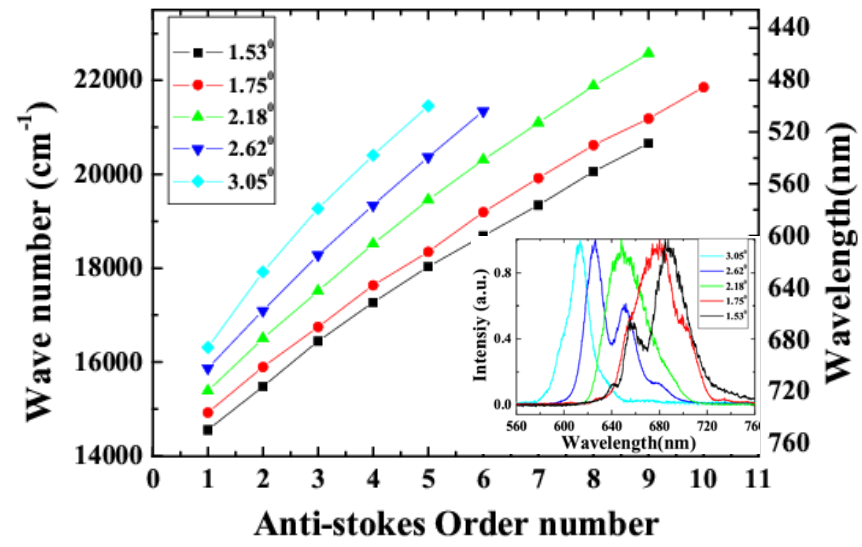
Figure 20. The center spectrum (wavenumber) of different sidebands varies with the anti-Stokes order number when the crossing angle between two input beams is 1.53º, 1.75º, 2.18º, 2.62º and 3.05º. The inset is the spectrum of the first order